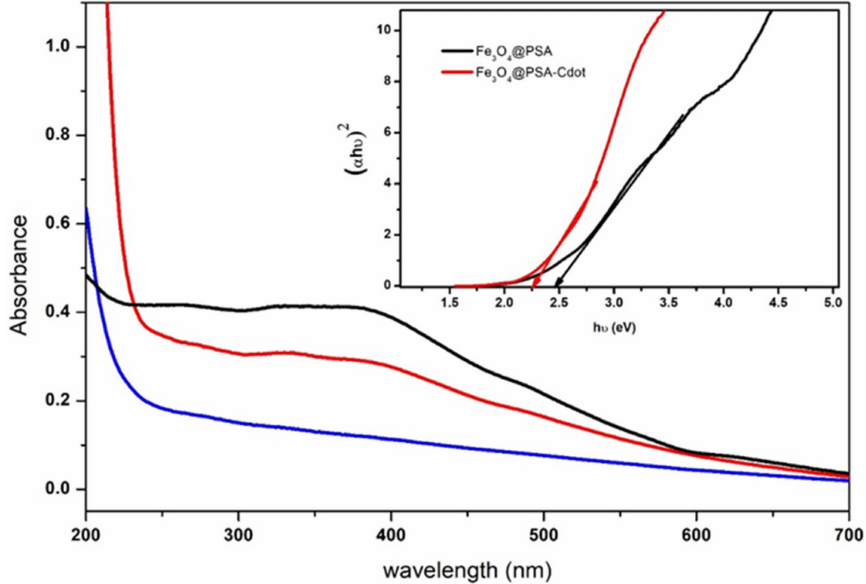
Figure 5. The plot ( α h ν ) 2 vs. h ν represents the energy bandgap (Eg) of the Fe 3 O 4 and Fe 3 O 4 @PSA-C